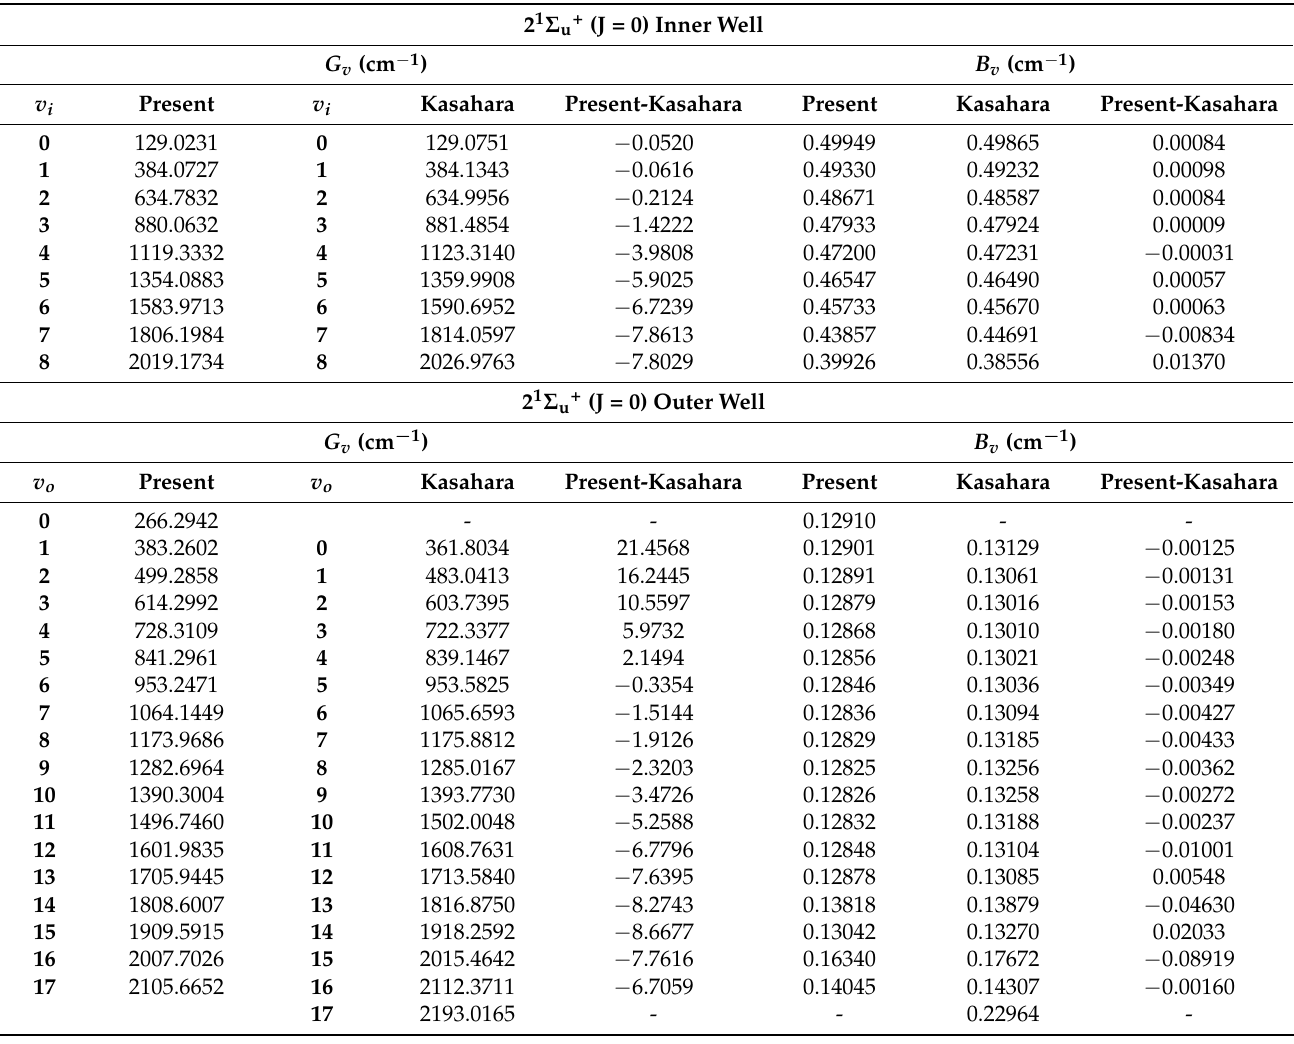
Table 2. Vibrational energy levels of 2 1 Σ u+ (J = 0) of 7 Li 2